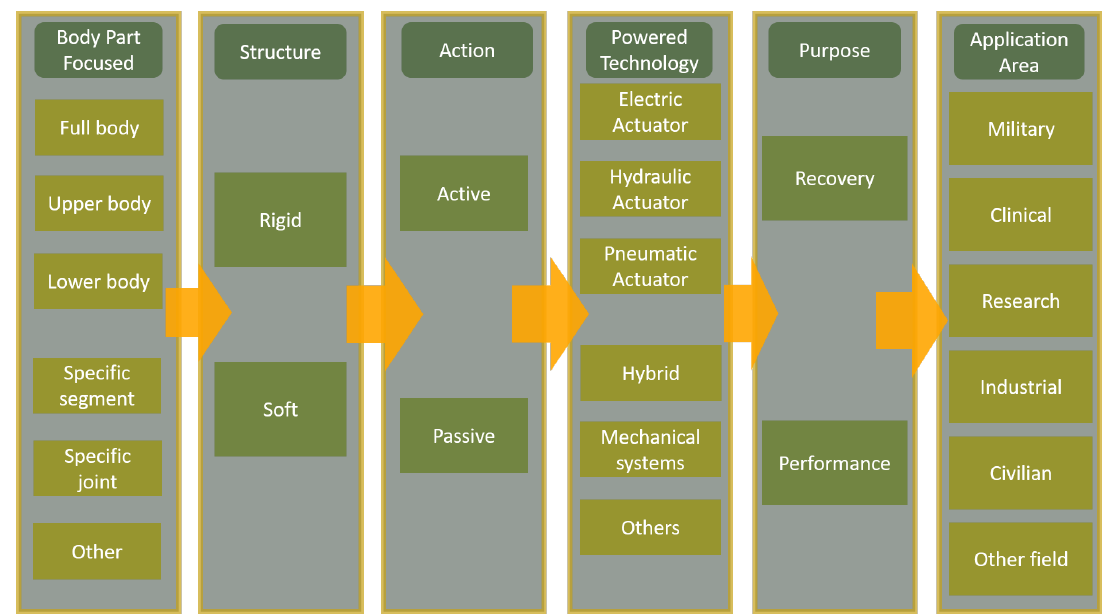
Figure 5. General categorization model proposal for